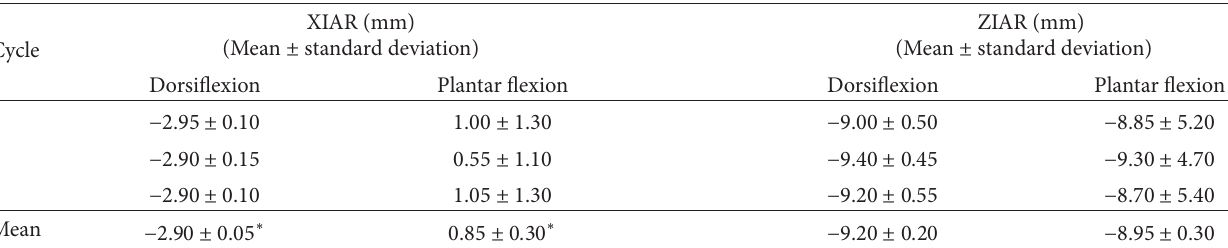
Table 2: Mean IAR values for specimen